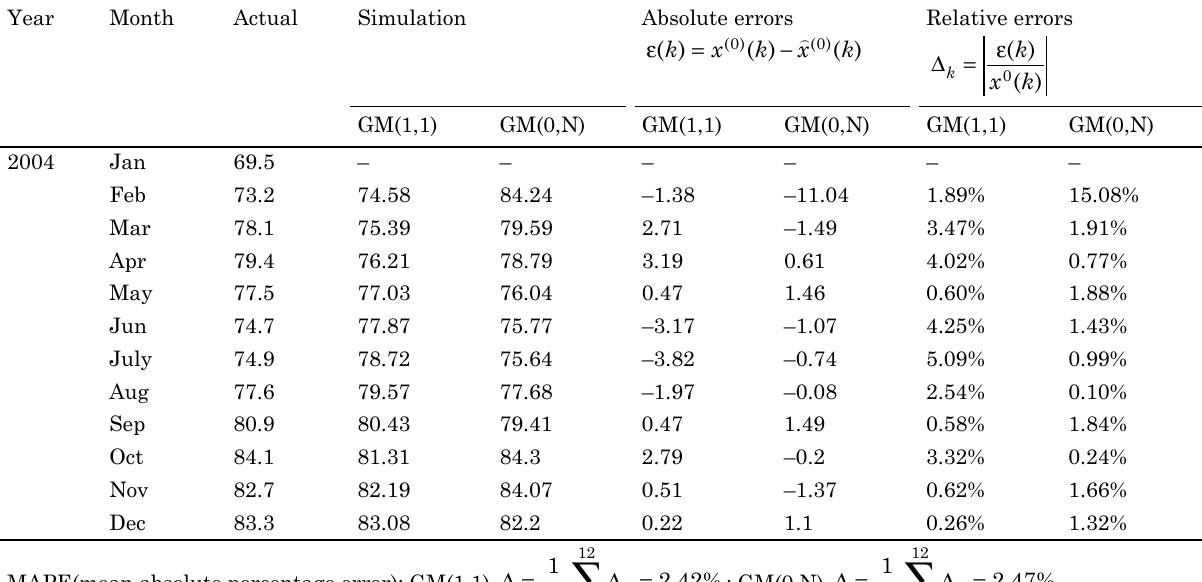
Table 2. The GM(1,1) and GM(0,N) forecasting errors